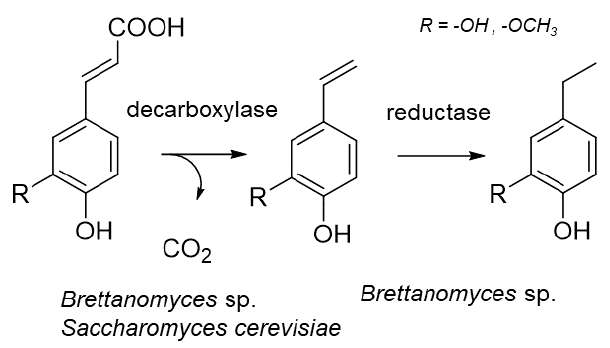
Figure 3. Formation of allyl- and ethylphenols by yeast during fermentation.